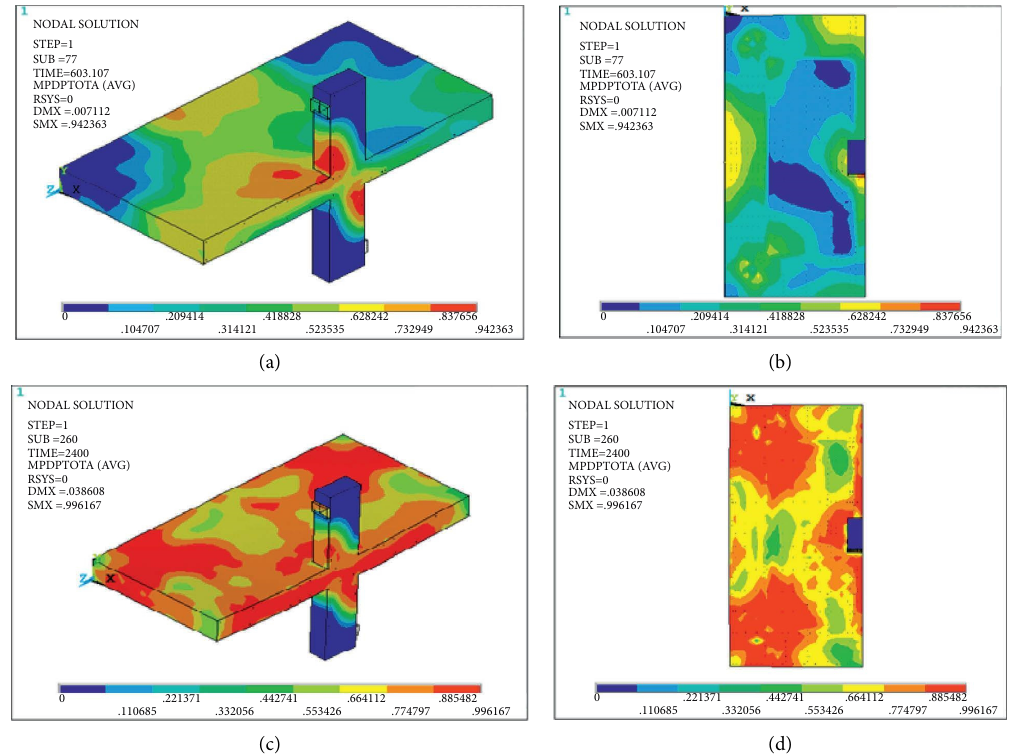
Figure 33: Total concrete damage to control specimen due to 2400sec fre exposure at the bottom of the slab. (a) Total concrete damage at maximum load. (b) Bottom surface total concrete damage at maximum load. (c) Total concrete damage at failure load. (d) Bottom surface total concrete damage at failure